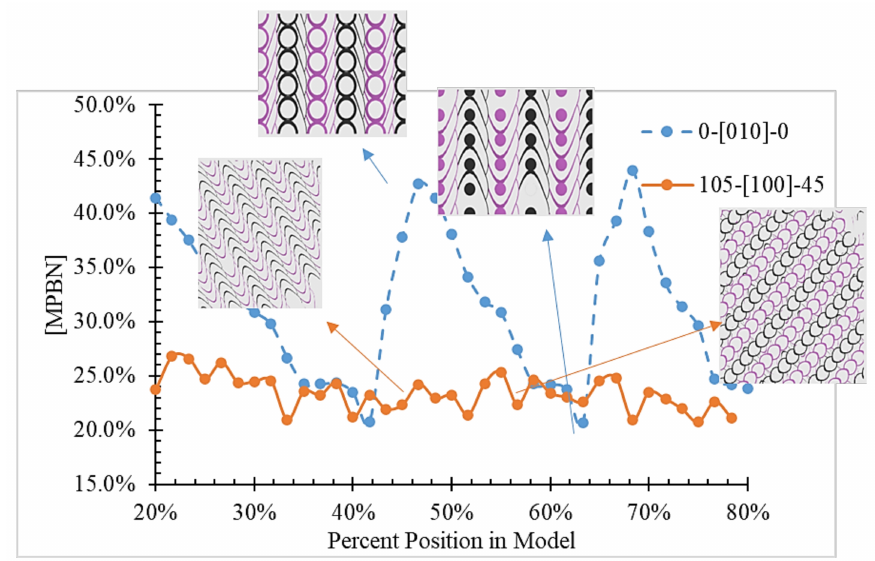
Figure 12. Plot of MPBN concentration over the length of the model.